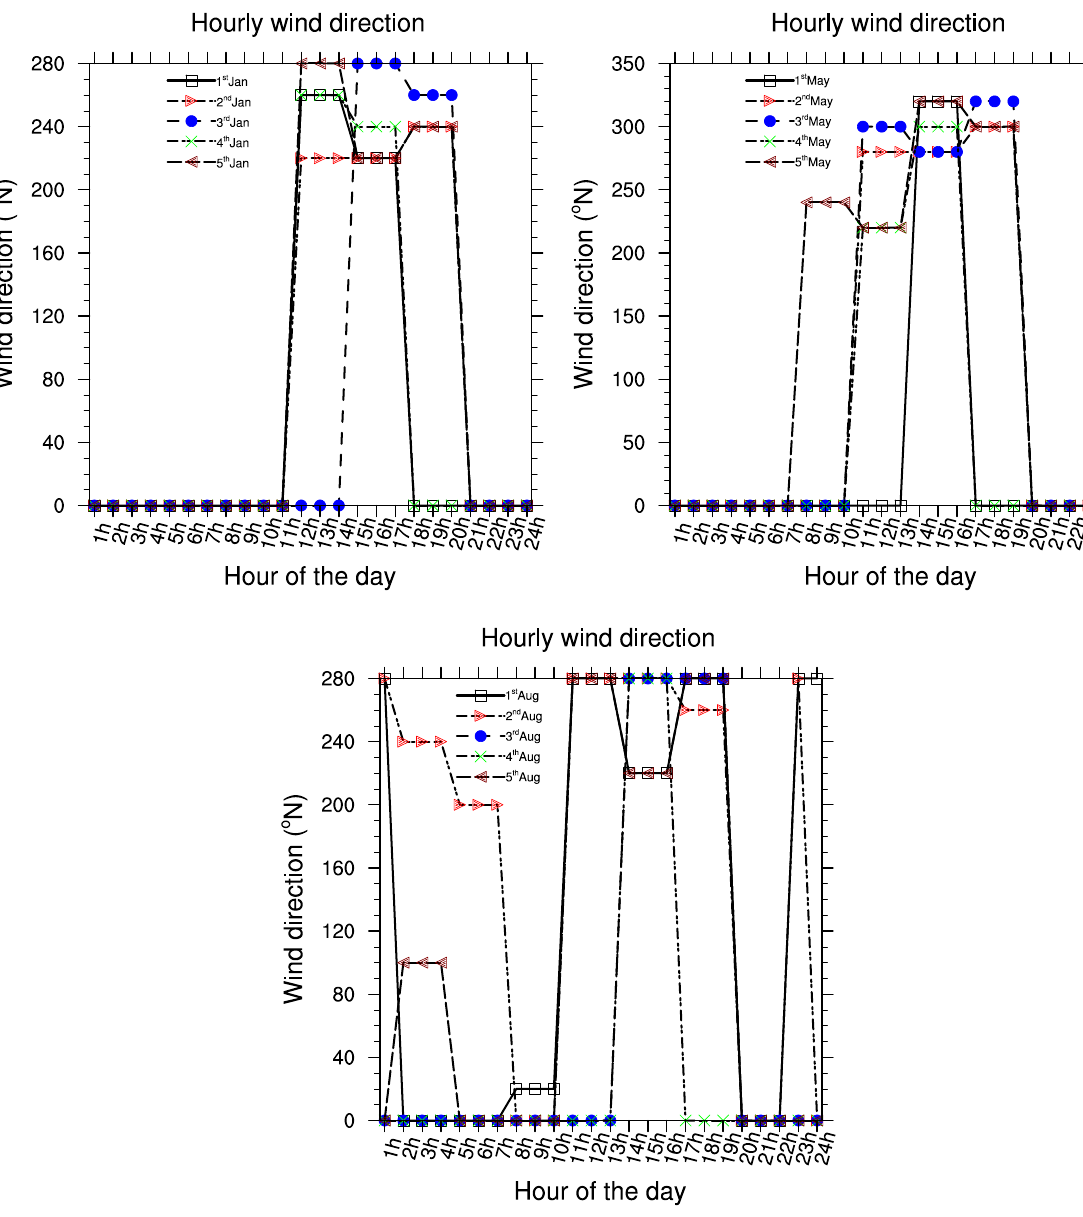
Figure 4. Daily wind direction for the first five days of the months of January, May and August for the year